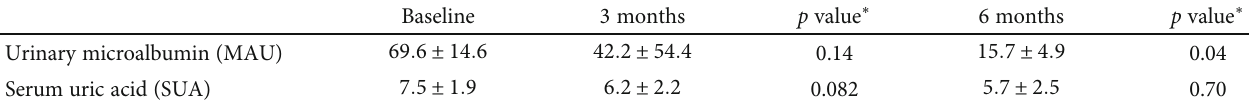
Table 3: Change in MAU and SUA after 3 and 6 months of treatment in non-ARB group ( n = 79 ). Baseline